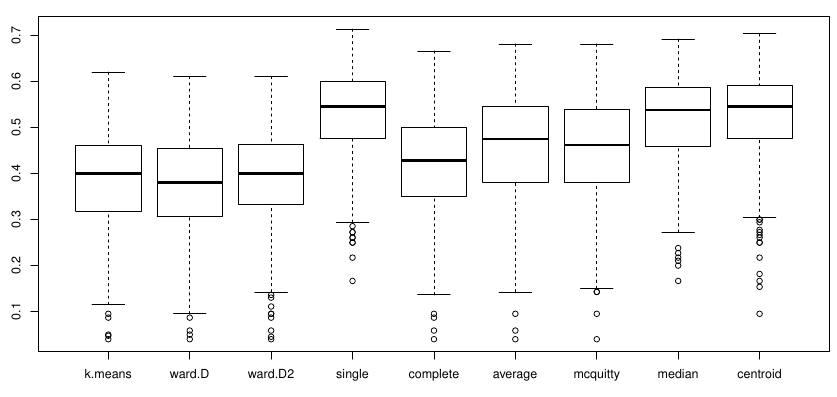
Figure 3. Box plots of simulated MEs using various clustering methods in the second stage of WNACut for γ 1 = 64.